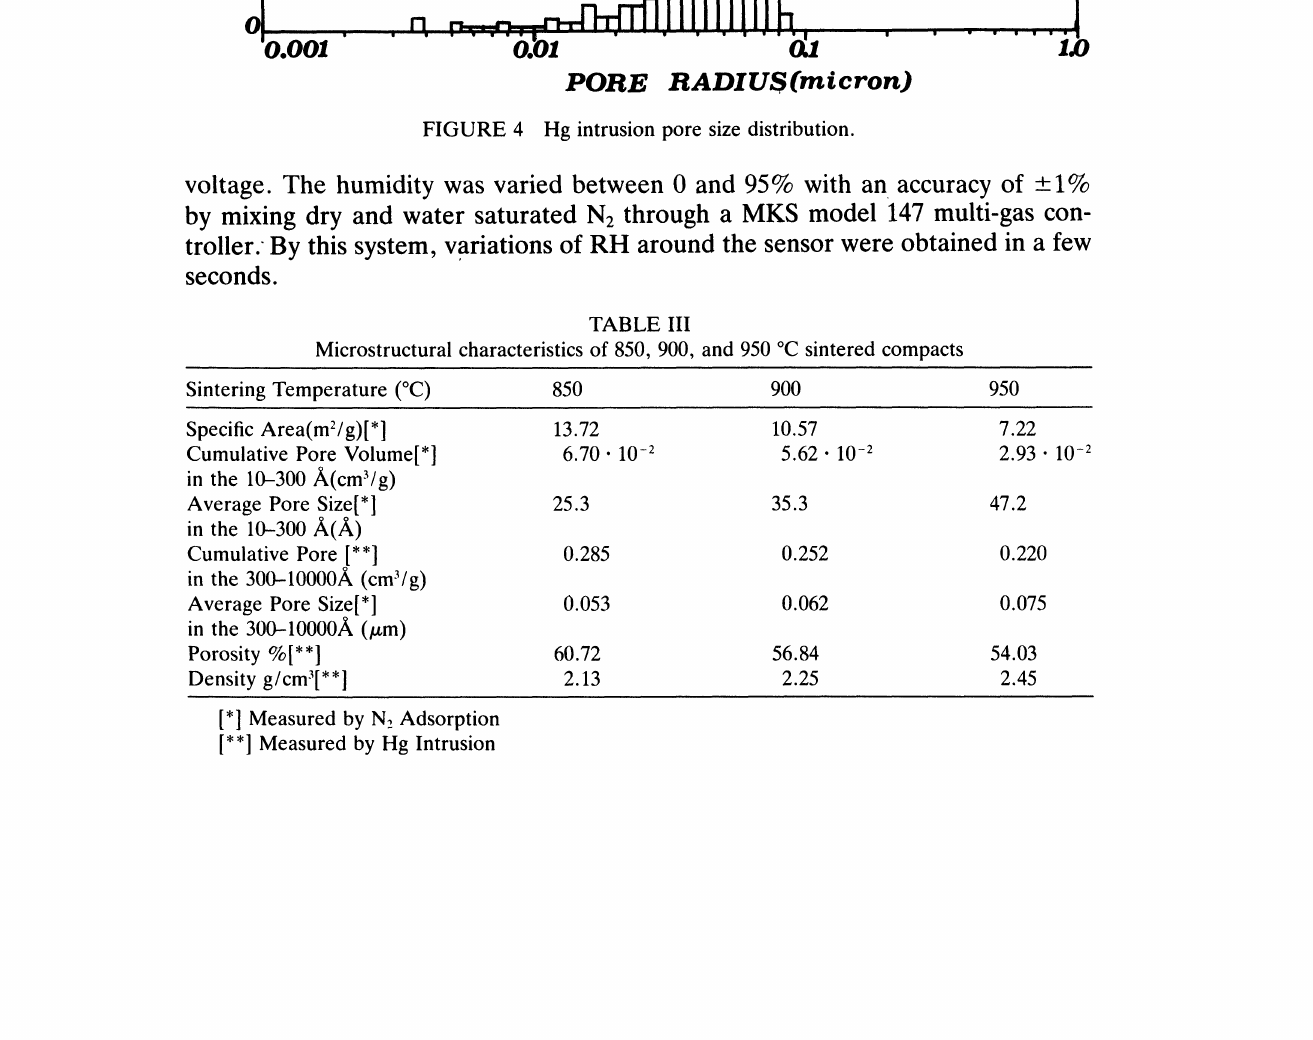
FIGURE 4 Hg intrusion pore size